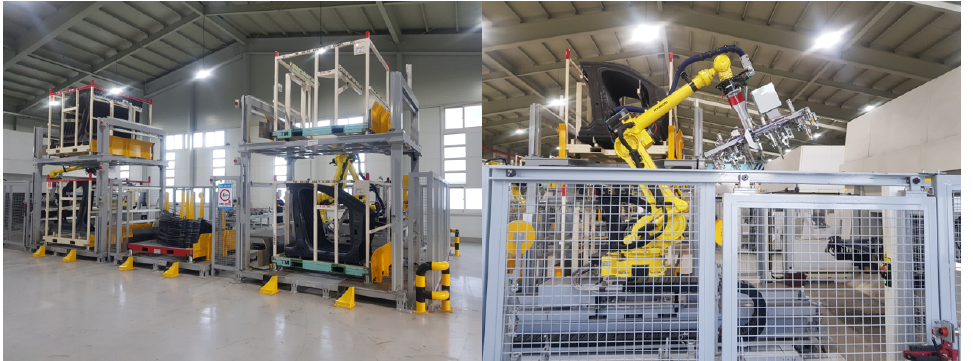
Figure 9. Automated facilities of Company